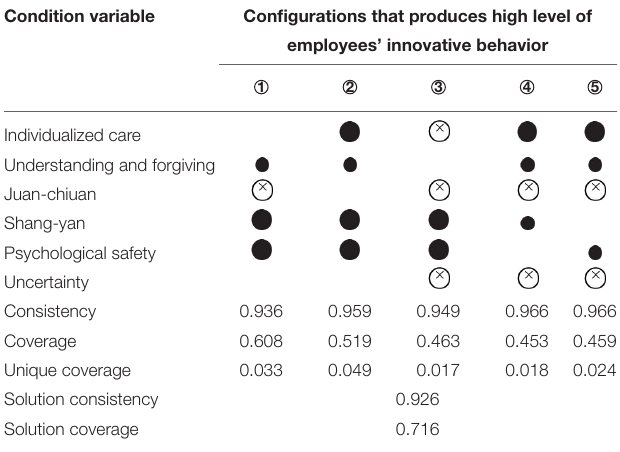
TABLE 5 | Configuration analysis